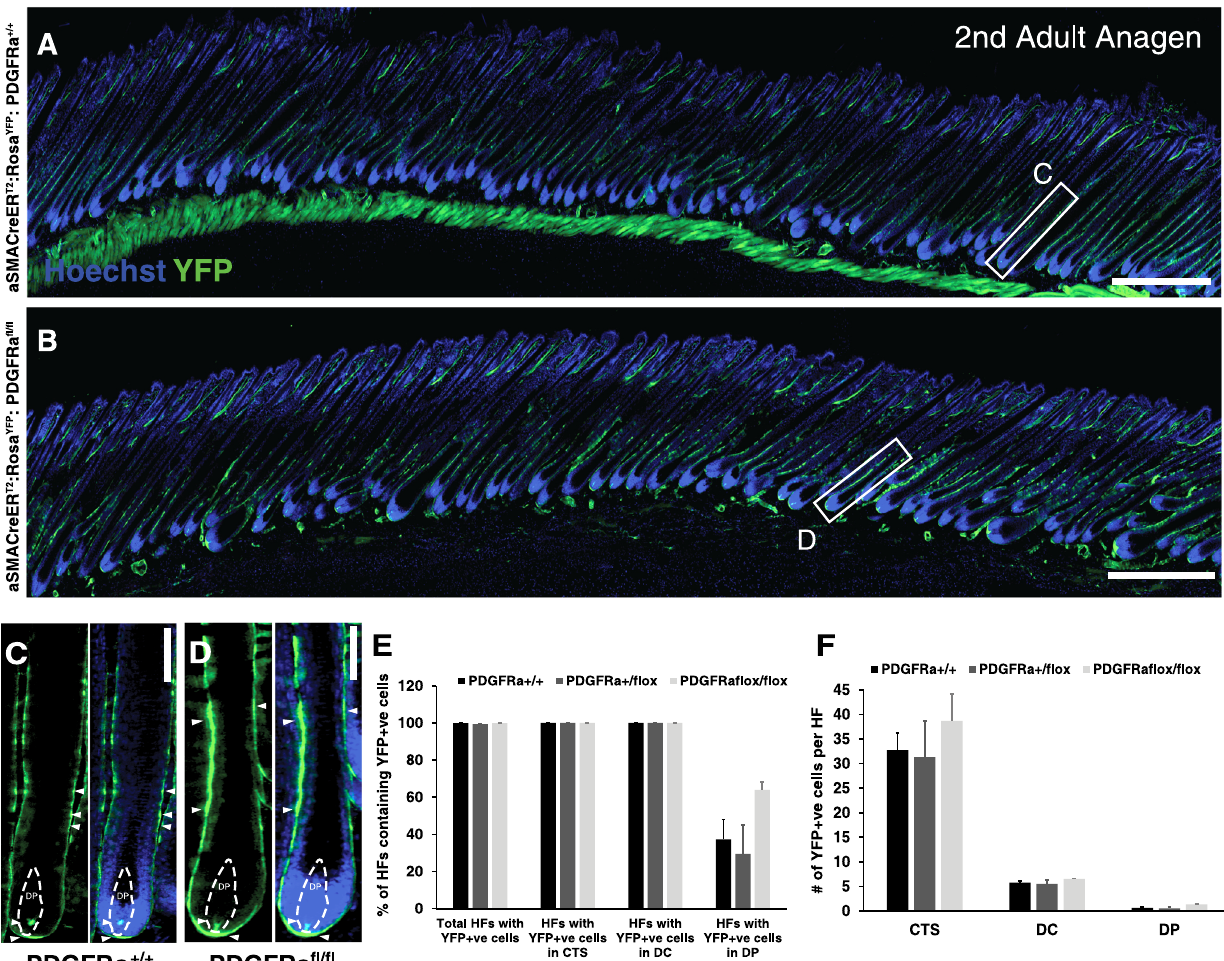
Fig. 1 In vivo fate mapping of Pdgfr α - de fi cient hfDSCs during second adult anagen. a Skin from α SMACreER T2 : Rosa YFP :Pdgfr α +/+ or b Pdgfr α fl ox/ fl ox animals after Cre-induced recombination. The backs of the animals were depilated at P21 (telogen) and tamoxifen was administered by gavage at P21, P23, and P25 (1 mg/day/animal). The subsequent anagen phase was documented and compared between tamoxifen-treated wild-type ( n = 3), heterozygous ( n = 4), or Pdgfra fl ox/ fl ox ( n = 3), carrying Cre animals. Skin was harvested during second anagen (P33-P35). c Magni fi ed view of an individual HF from Pdgfr α +/+ skin ( white box in ( a )) showing YFP +ve cells ( green, arrowheads ) in each of the dermal compartments of the HF, i.e., CTS, DC, and DP outlined by dashed lines . d Magni fi cation of a HF from Pdgfr α fl ox/ fl ox skin ( white box in ( b )) for comparison. e Percentage of HFs containing YFP +ve cells. Total number of YFP +ve HFs per genotype are represented, as well as the percentages of HFs with YFP +ve cells present in each dermal compartment. f Mean number of YFP +ve cells per HF present in each component of the dermal compartment in Pdgfr α +/+ ; Pdgfr +/ fl ox and Pdgfr α fl ox/ fl ox animals. Data are mean ± SEM ( n = 10 animals). Kruskal – Wallis test ( p = n.s.). Scale bar represents 500 ( a , b ) or 50 µm ( c , d ). See also Fig.